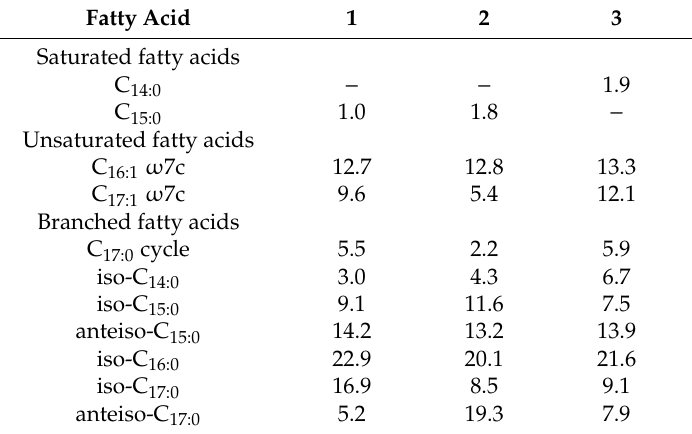
Table 2. The cellular fatty acid compositions of strain LD120 T and its closely related strains. Fatty